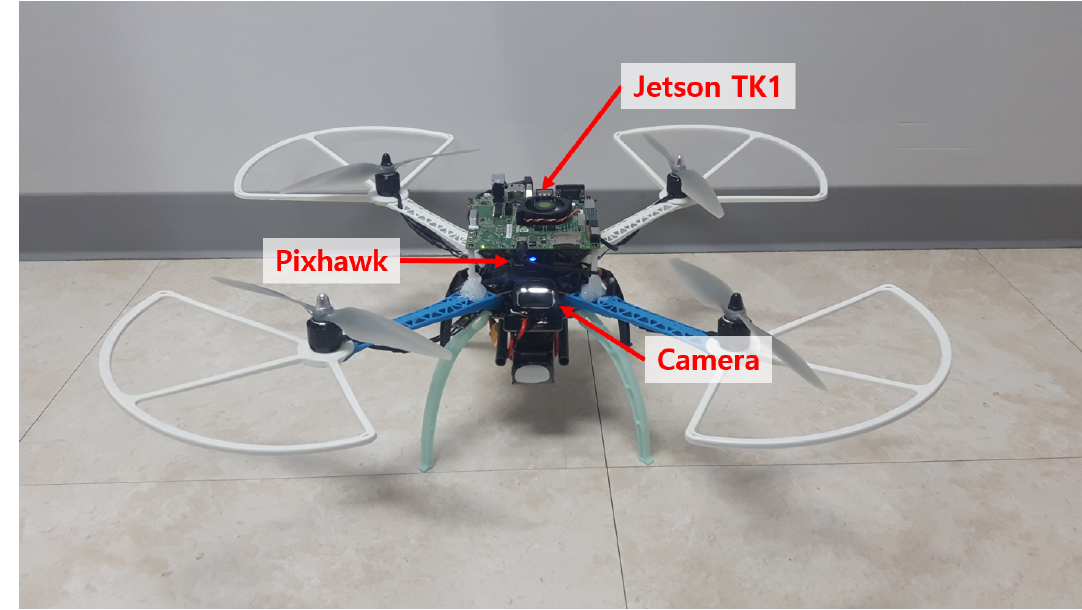
Figure 14. Customized MAV.